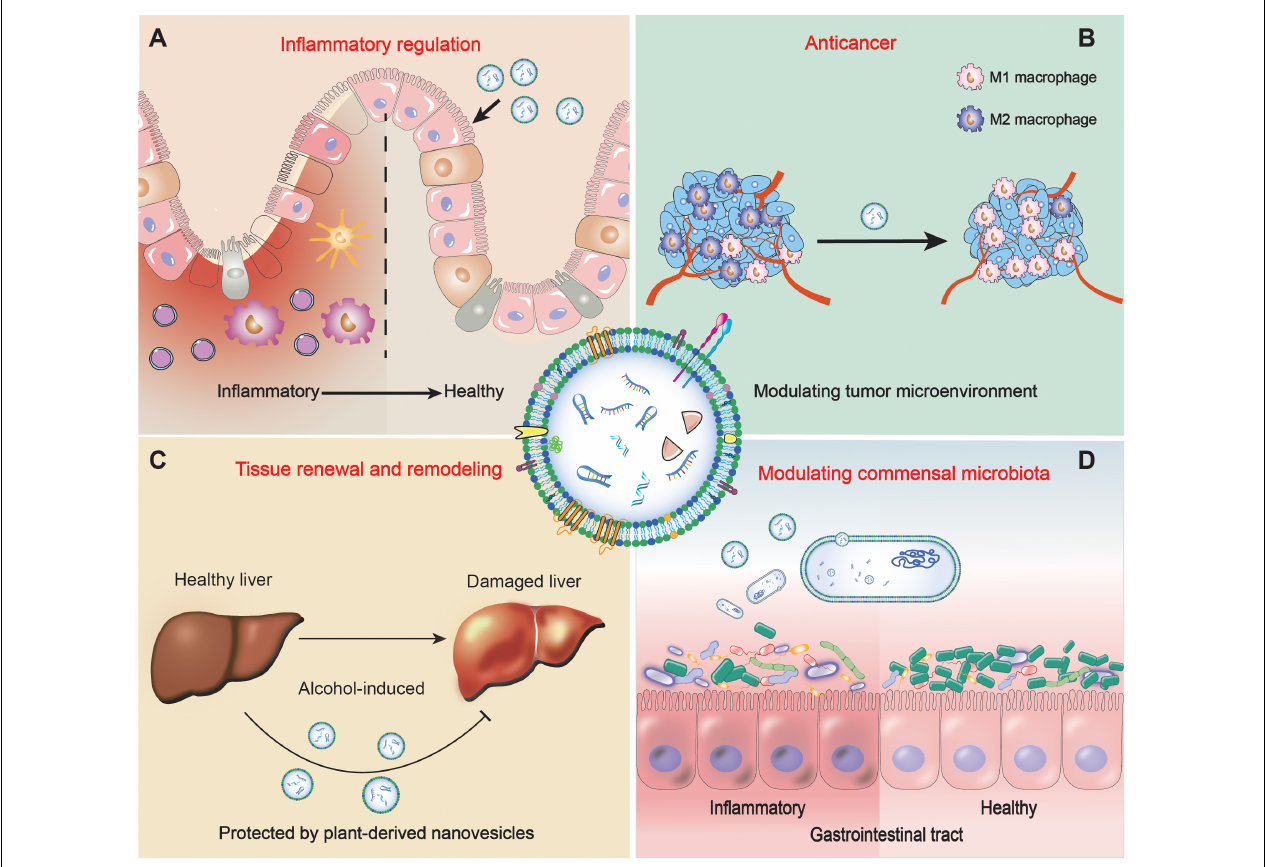
FIGURE 1 | Schematic representations of medical applications of plant-derived nanovesicles (A) in inflammation regulation, (B) in anticancer, (C) in tissue renewal and remodeling, (D) in modulating commensal